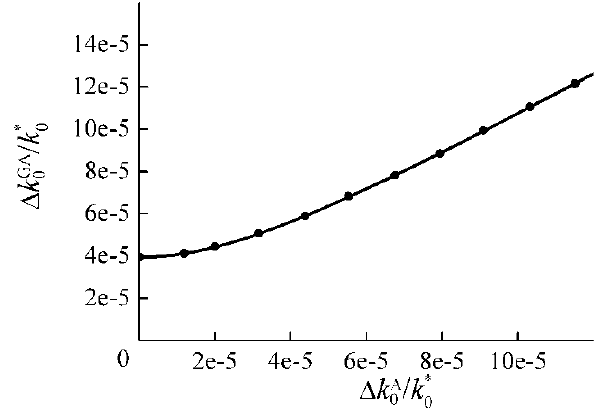
k ∆ at a fixed G k ∆ on A 0 0